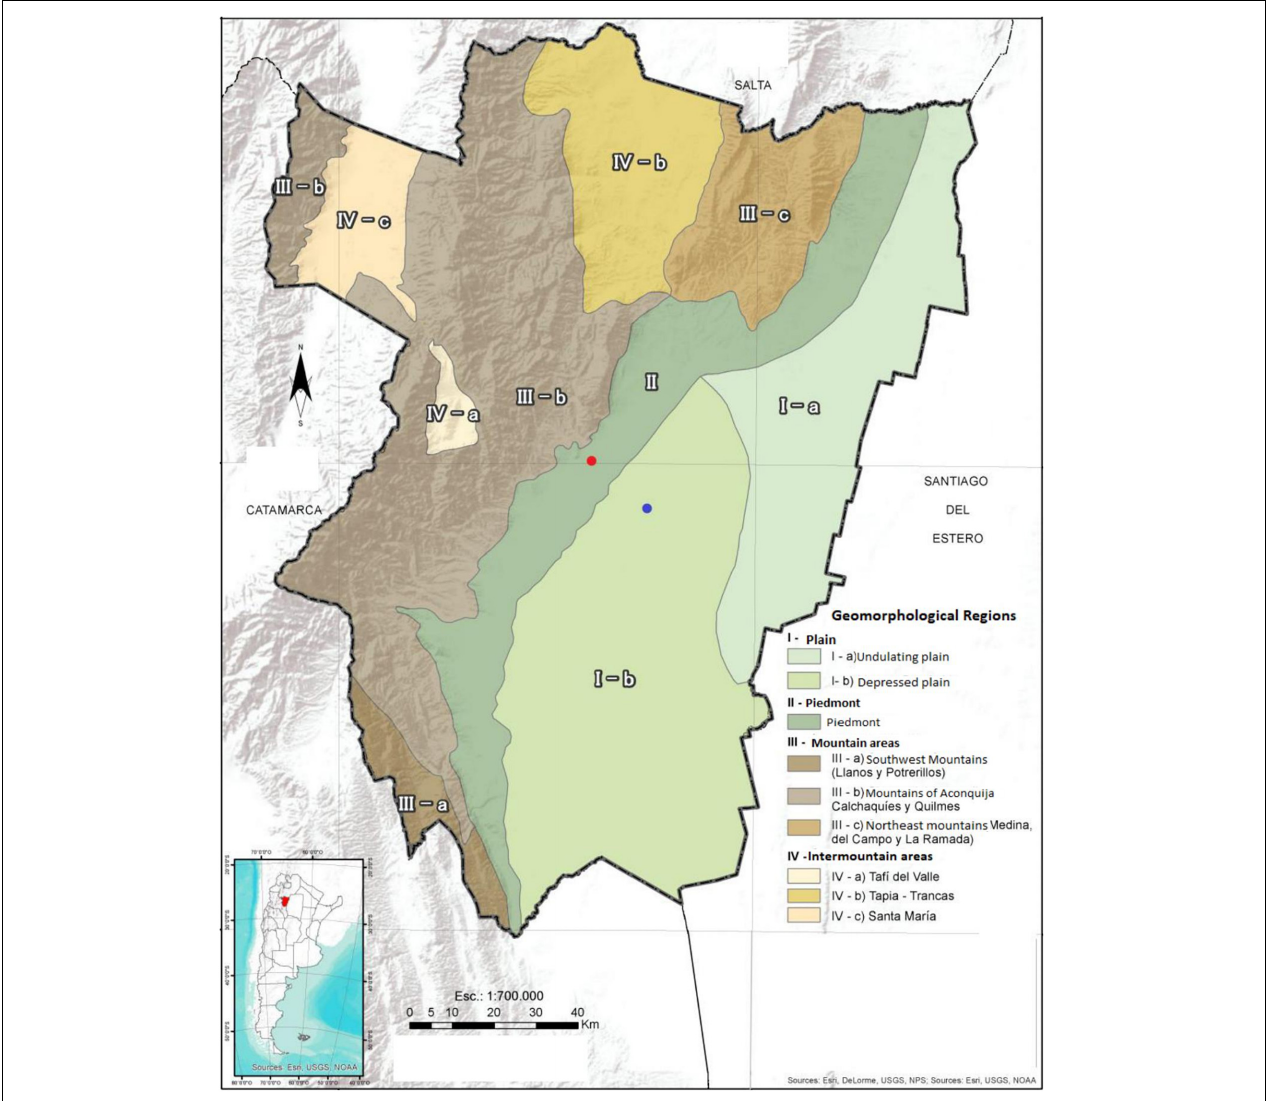
FIGURE 1 | Geographic location of Leales (in blue) and Famaillá (in red) apiaries. Map of Tucumán province with geomorphic divisions modified from Collantes and Busnelli (2014) [see lower left box for location of Tucuman province (red dot) on the map of Argentina].